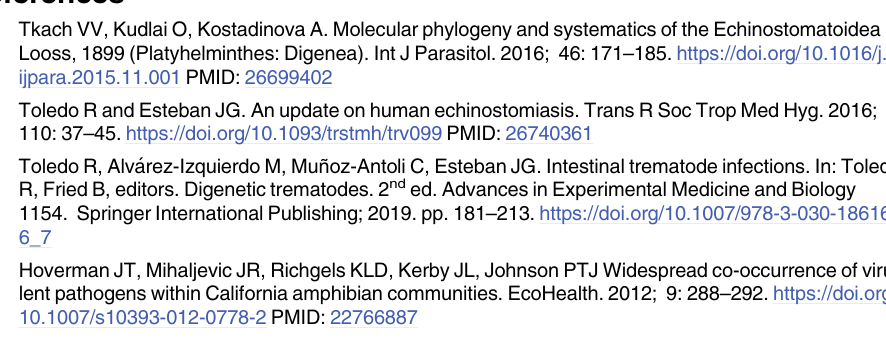
S4 Table. Summary data for Echinostoma revolutum ( s . s .) isolates from Europe and Asia used in molecular diversity and population structure